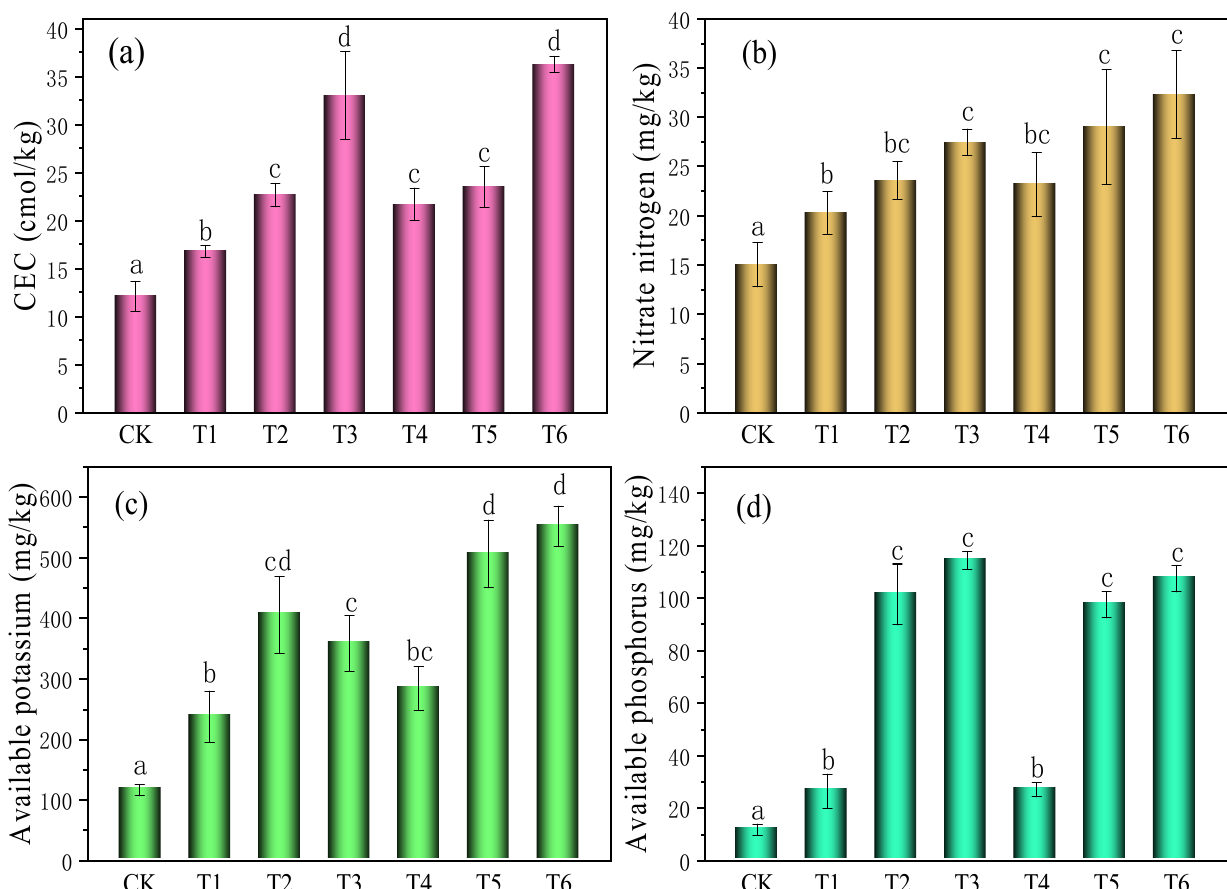
Figure 1. Effects of different treatments on soil CEC ( a ), nitrate N ( b ), available K ( c ), and available P ( d ). Soil control (CK), the amount of colloidal BC accounts for 3% of dry soil weight (T1), the amount of organic fertilizer accounts for 3% of dry soil weight (T2), 1.5% colloidal BC +1.5% organic fertilizer (T3), 3% colloidal BC + Methyltrophic bacillus (T4), 3% organic fertilizer + Methyltrophic bacillus (T5), 1.5% colloidal BC + 1.5% organic fertilizer + Methyltrophic bacillus (T6). Data with different letters are significantly different ( p < 0.05).